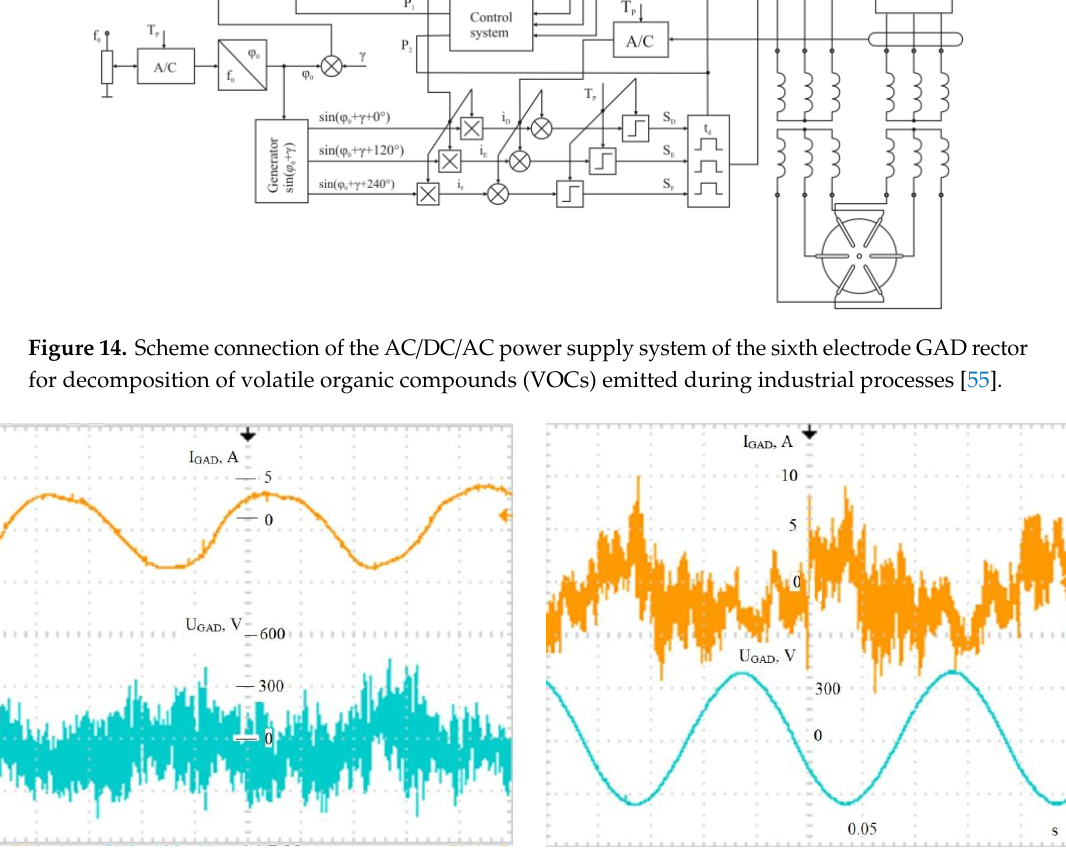
Figure 14. Scheme connection of the AC/DC/AC power supply system of the sixth electrode GAD rector for decomposition of volatile organic compounds (VOCs) emitted during industrial processes [55].